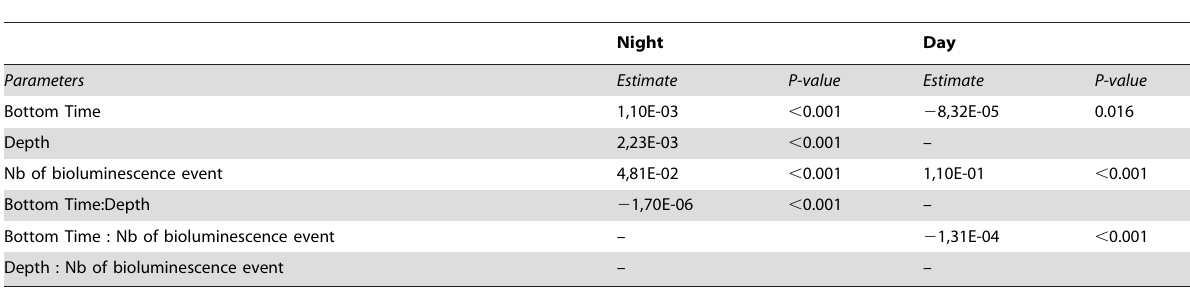
Table 1. Bioluminescence and index of foraging intensity.